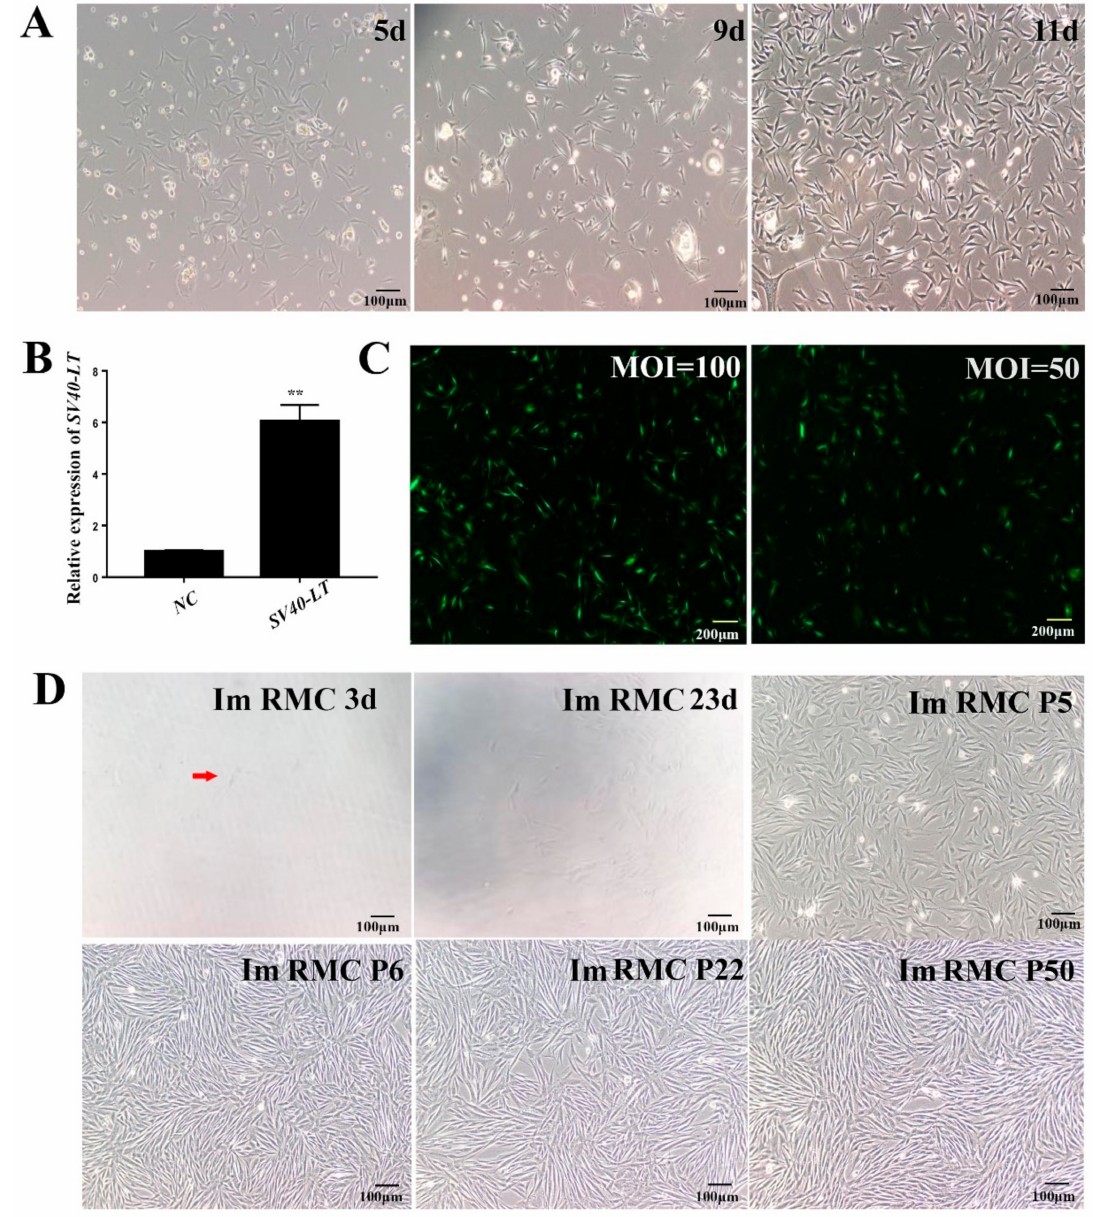
Figure 1. Immortalization of rabbit melanocyte cells using simian virus 40 Large T (SV40-LT) lentiviruses ( A ) Isolation and morphological observations of primary melanocytes (100 × ). ( B ) Identification of LV-SV40LT lentivirus-expressing cells. PLVX-IRES-Puro was used as normal control (NC, 40 × ). An extremely significant di ff erence was signified with “**” (p < 0.01). ( C ) Fluorescence analysis of pLVX-IRES-Puro-GFP infection after 48 h. ( D ) Monoclonal selection in which 3d / 23 d indicates the 3rd / 23th day after monoclonal selection. Im RMC P5 / P6 / P22 / P50 indicates the Im RMCs at passage 5 / 6 / 22 / 50 (100 × ). Arrows indicate monoclonal cells. MOI: multiplicity of infection; Im RMC: immortalized rabbit